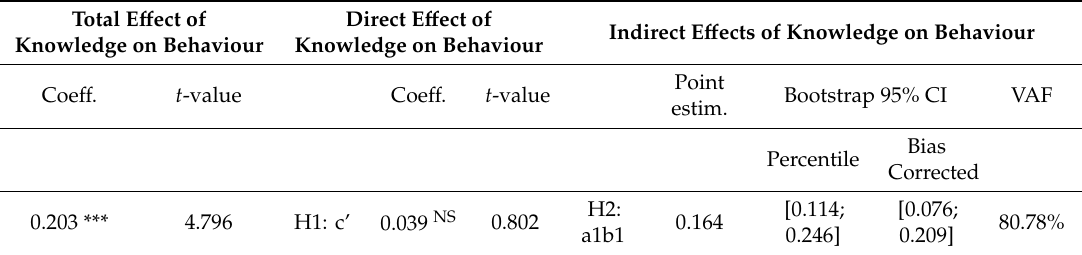
Table 4. Summary of mediating e ff ects.